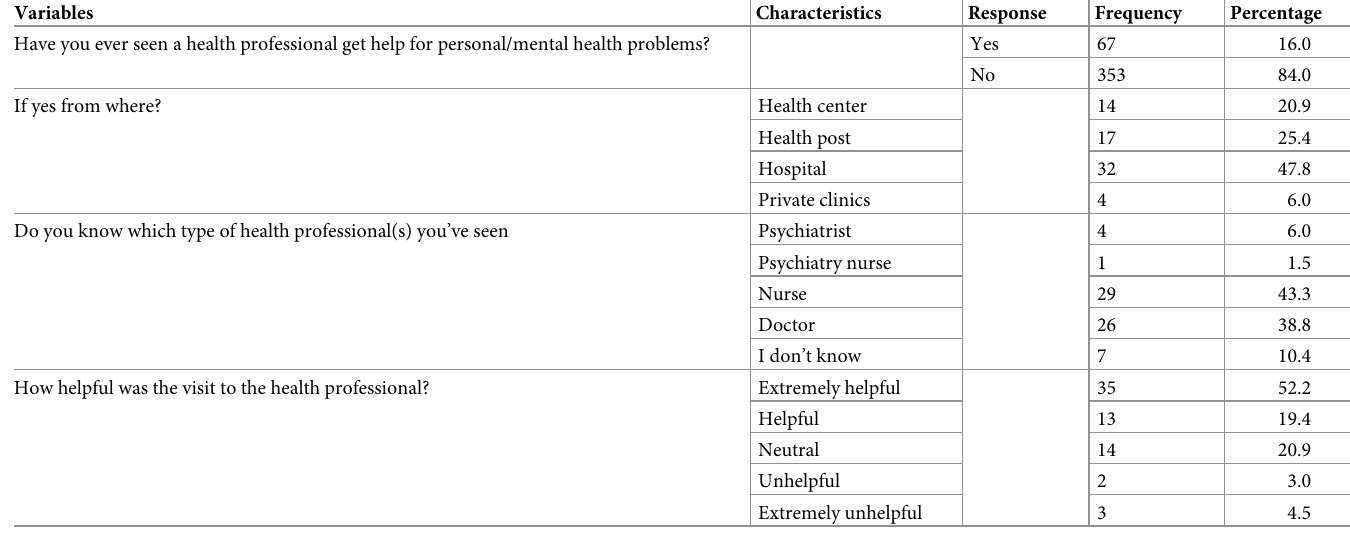
Table 5. Help-seeking experience of the respondents towards mental health and mental health problems at Jimma Zone, Seka Chekorsa district Oromia, Ethiopia, March 2020. Variables